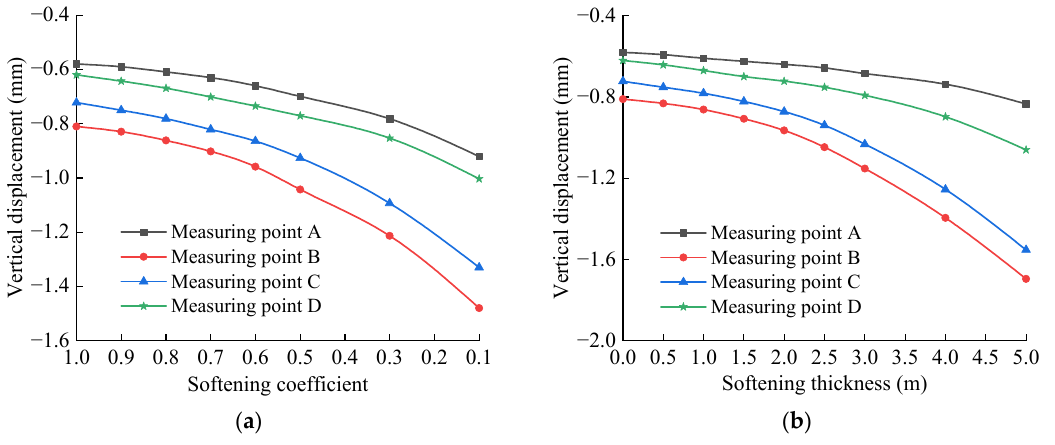
Figure 10. Vertical displacements peak change curve of base measuring point: ( a ) Relationship be- tween vertical displacement and softening coefficient; ( b ) Relationship between vertical displacement and softening thickness.